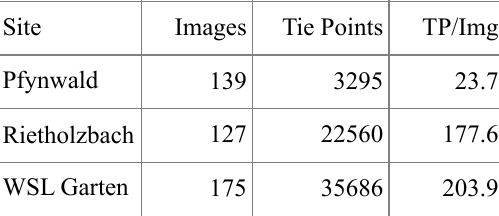
Table 3: Tie point density for all test